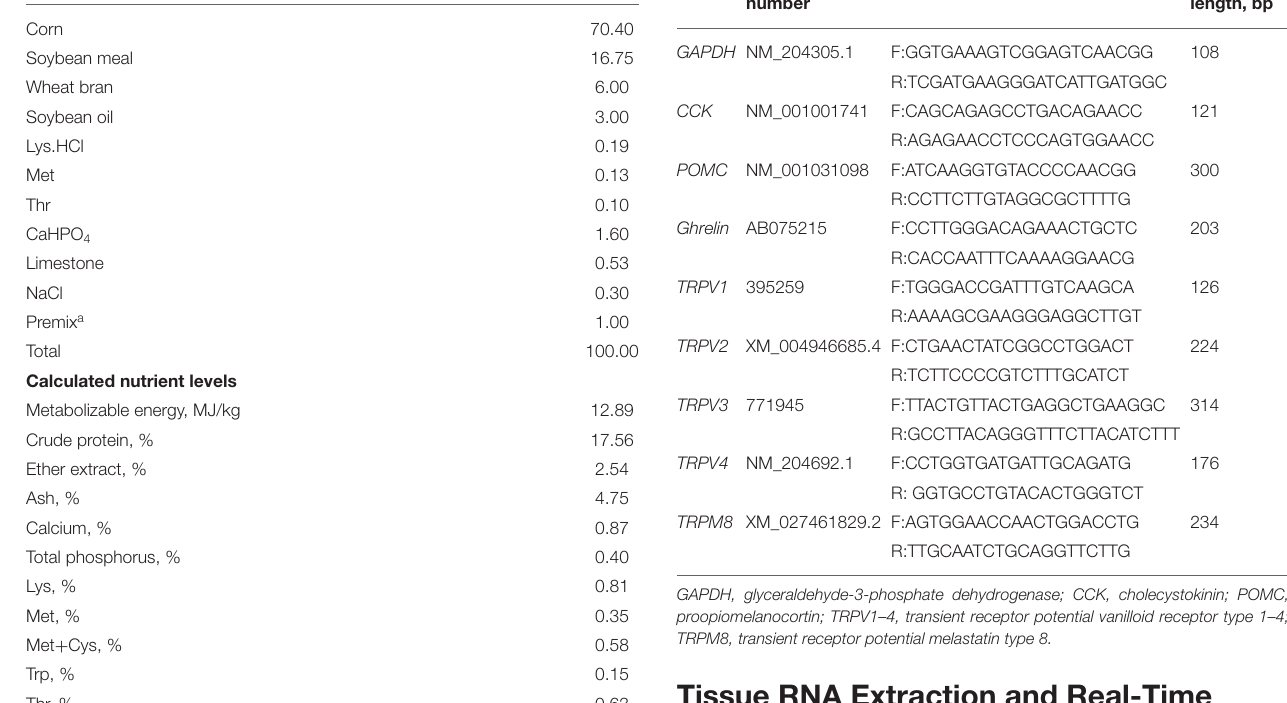
TABLE 1 | Composition and nutrient levels of the basal diet (air-dry basis, %). Ingredients